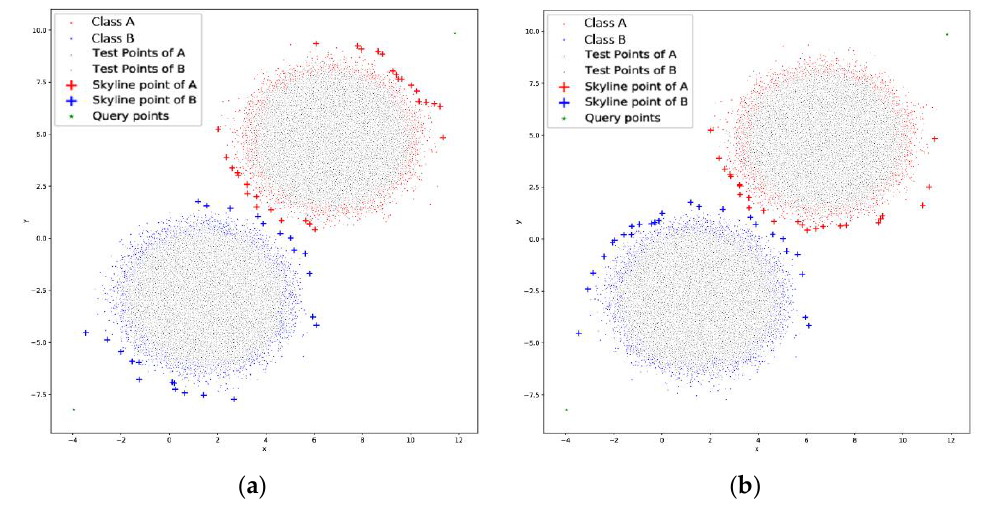
Figure 4. ( a ) Opposite skyline; ( b ) smart skyline.